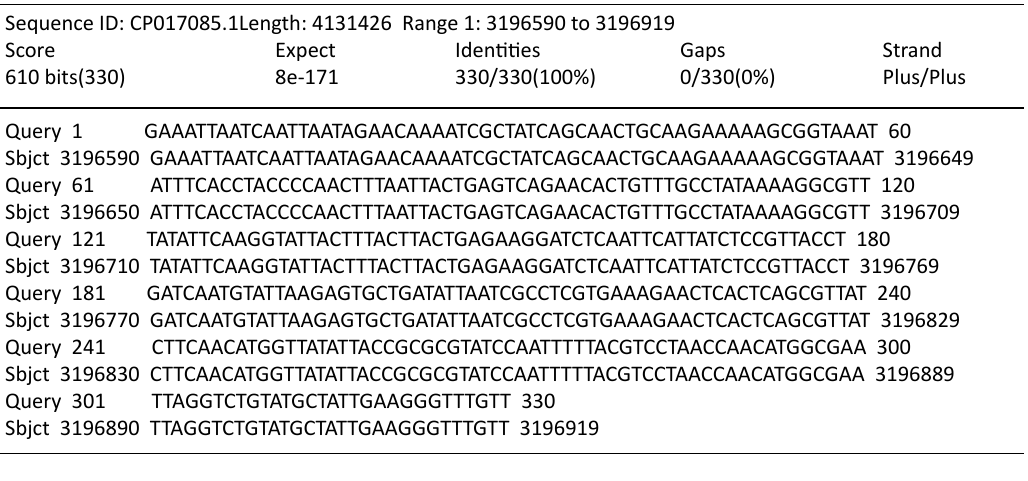
table 5. Alignment of hpmB gene sequence Proteus mirabilis strain